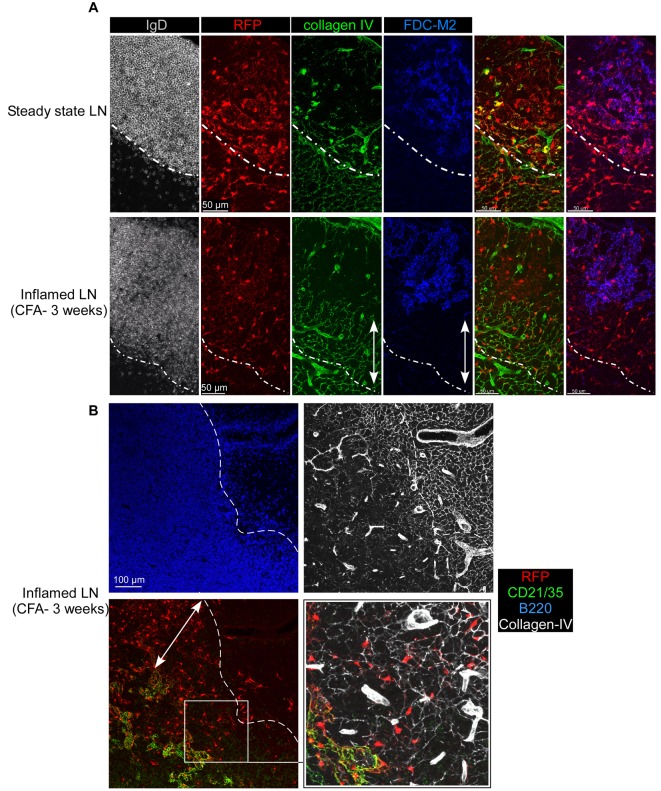
CD21− RFP+ stromal cells are surrounded by inflamed B cell follicles.CD21cre-RFP chimeras were untreated (A, upper panel) or injected (A, lower panel and B) with an emulsion of CFA/PBS in the ears. (A) Three weeks later, ear draining LNs were sectioned, stained for collagen IV (green), IgD (white), and FDC-M2 expression (blue) and imaged by confocal microscopy. RFP+ cells appear in red. (B) Confocal pictures of an inflamed B cell follicle stained for collagen IV (white), B220 (blue), and CD21/35 (green) expression. Arrows highlight the region of the inflamed B cell follicle enriched in collagen IV. Insert displays high magnification of the boundary between T and B cell areas (dashed line). Data are representative of three different experiments (two mice per experiment).